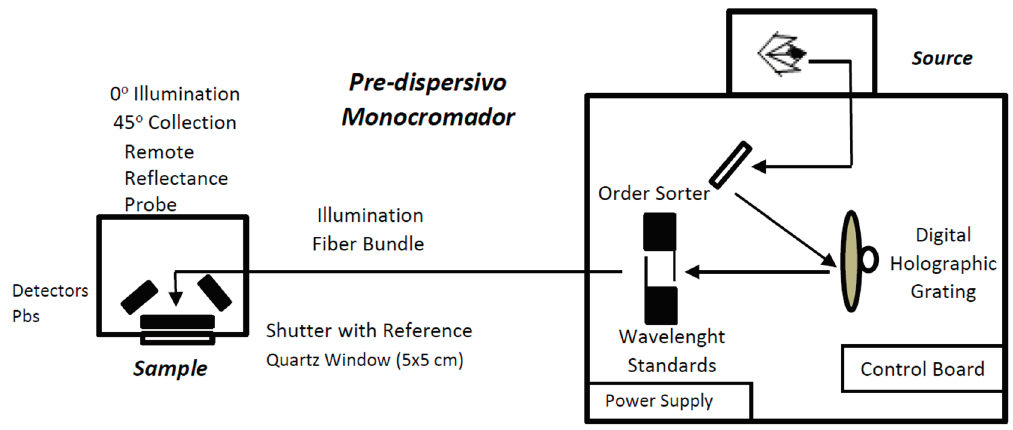
Figure 1. Schematic of the used NIRS equipment with fiber optic